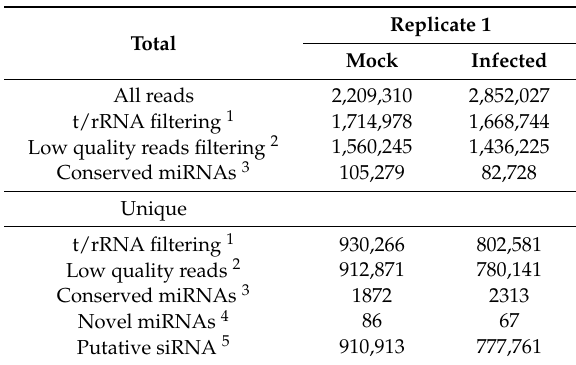
Table 1. Summary of sequencing data from the small RNA